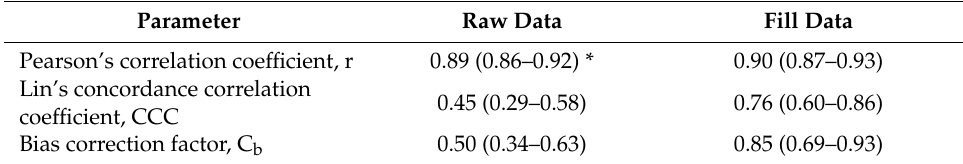
Table 8. Correlations between duration (minute) of total observed panting and sensor-recorded panting. Parameter Raw